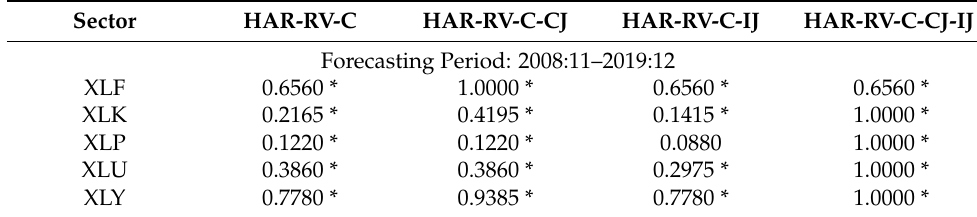
Table 10. Model confidence set test *.